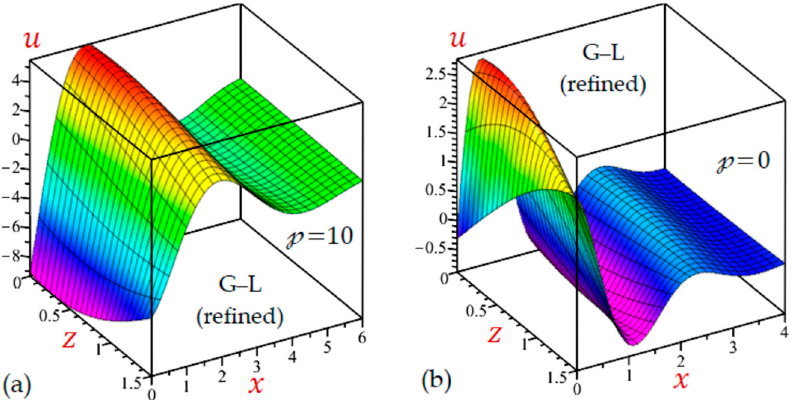
initial pressure ( 𝓅 = 10 ) and ( b ) without initial pressure ( 𝓅 = 0 ) using the refined L–S generalized